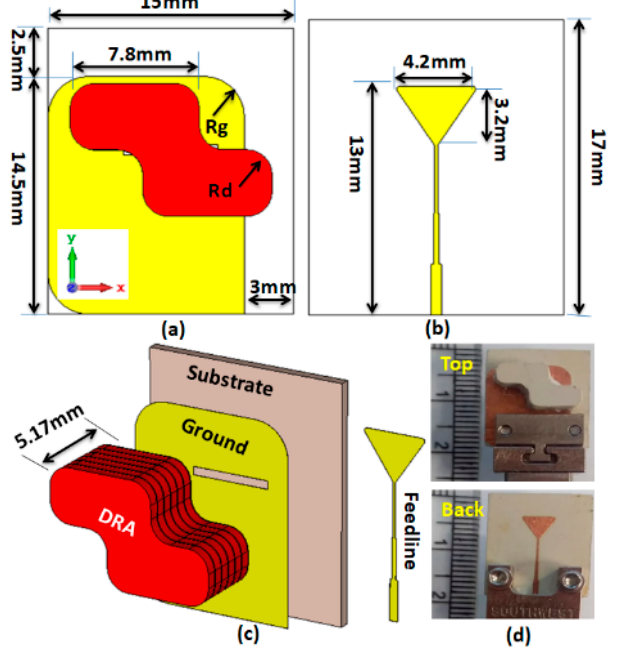
Figure 1. Single-element DRA layout: ( a ) 2D front view; ( b ) 2D back view; ( c ) 3D view; ( d ) fabricated prototype with single DR element.